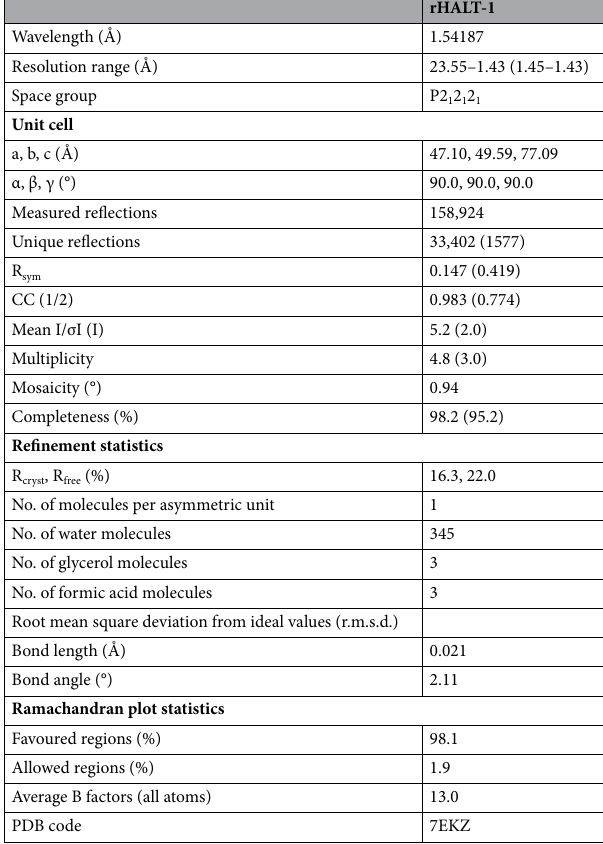
Table 1. Crystallographic data. Values for the outer shell are given in